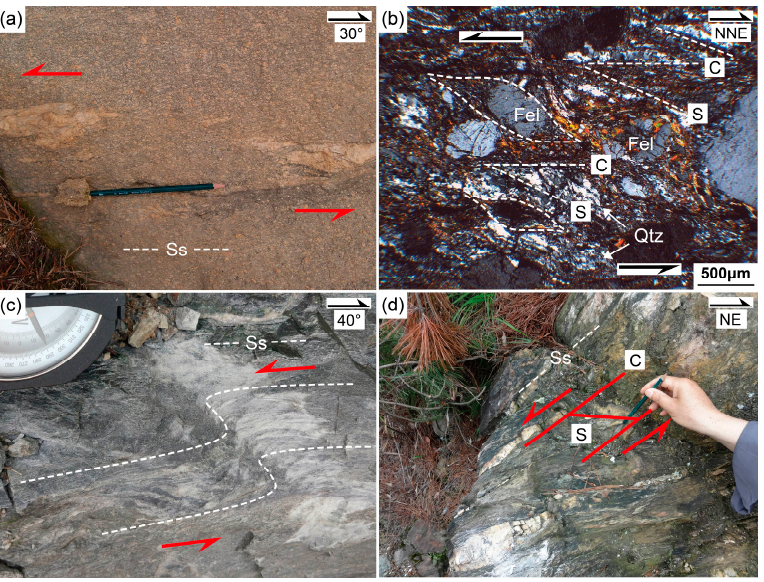
Figure 4. Field and microscopic photographs related to ductile strike-slip structures. “Ss” represents mylonitic foliation, and red arrows represent motion directions in the following figures. ( a ) Fold boudin that indicates the deformation direction in the XZSZ. ( b ) Sigma-shape feldspar porphyroblasts and oblique quartz grain shape fabrics indicating shear sense. ( c ) Asymmetric fold that shows the shear direction in the LHSZ. ( d ) S-C fabric indicating shear sense.